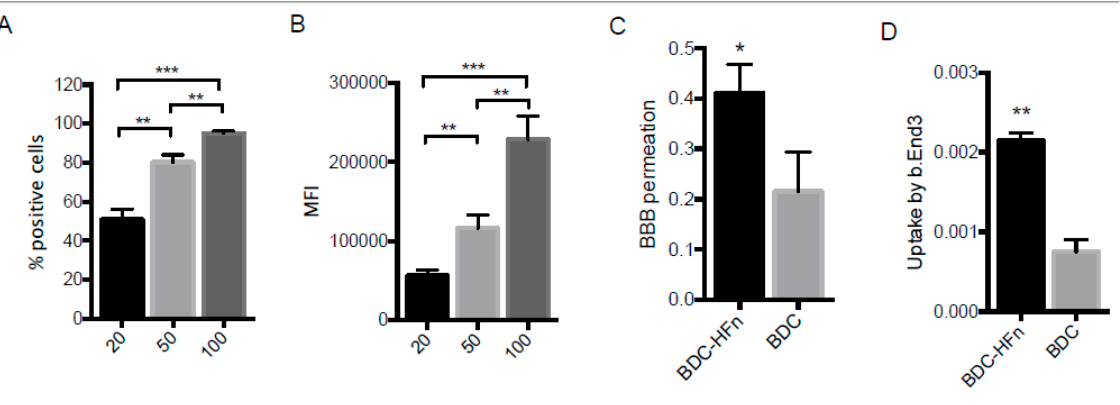
Figure 9. ( A ) Dose-dependent HFn binding to b.End3 endothelial cells was assessed by flow cytometry using 20, 50, and 100 μ g mL − 1 of FITC-labeled HFn. ( B ) Mean fluorescence intensity (MFI) of HFn-bound b.End3 cells. ( C ) Permeation of BDC-HFn or free BDC through an in vitro BBB model was calculated as the percentage of BDC collected in the lower compartment of treated transwells as compared to the incubated dose. ( D ) Percentage of uptake of BDC-HFn or free BDC by bEnd.3 cells. Reported values are the means of 3 replicates ± std. dev. * p < 0.05, ** p < 0.01, and *** p < 0.001